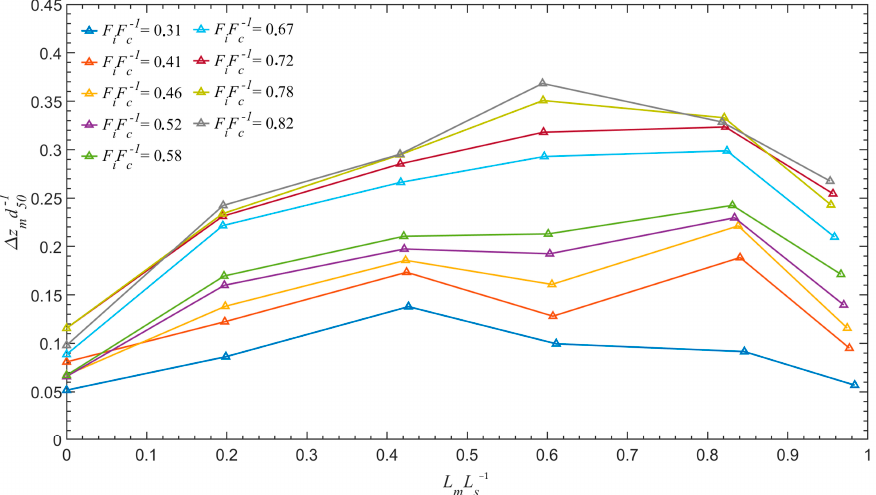
Figure 9. Example of values issued from test B displaying the riprap marked stone displacement along x -axis and z -axis according to normalized axial load values at the toe